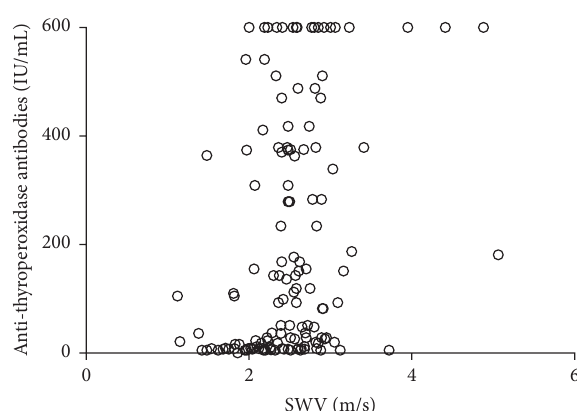
Figure 4: Correlation between shear wave velocity and serum titers of anti-thyroperoxidase antibodies.